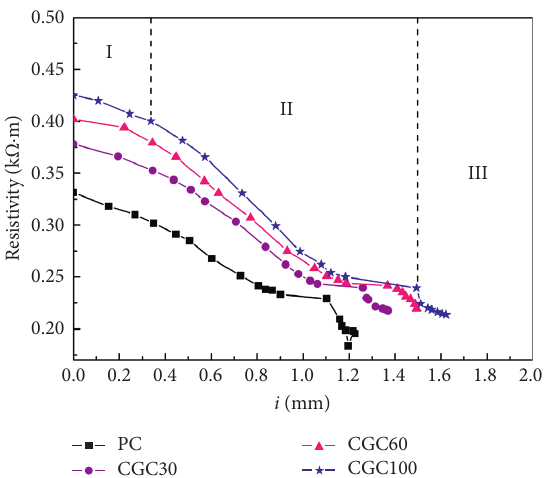
Figure 13: Relationship between resistivity and cumulative water absorption height.